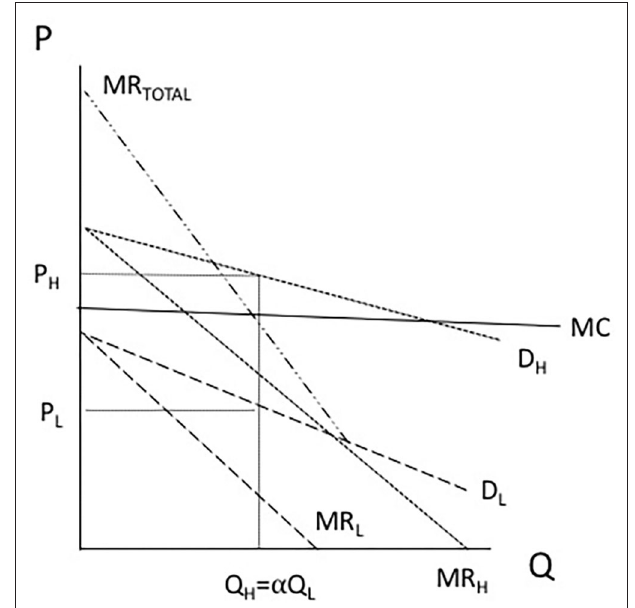
FIGURE 3 | Pricing of joint products under monopoly pricing. Adapted from (